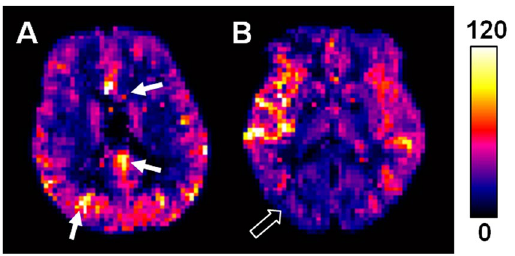
Figure 5. Representative CBF maps (in units of ml-blood/100 ml-tissue/min) derived from multi-PLD data for ( A ) the rightmost slice in Fig. 2 and ( B ) the leftmost slice in Fig. 3. Arrows indicate isolated hyperintensities. The open arrow indicates regional hypointensity as compared to single-PLD-derived value.